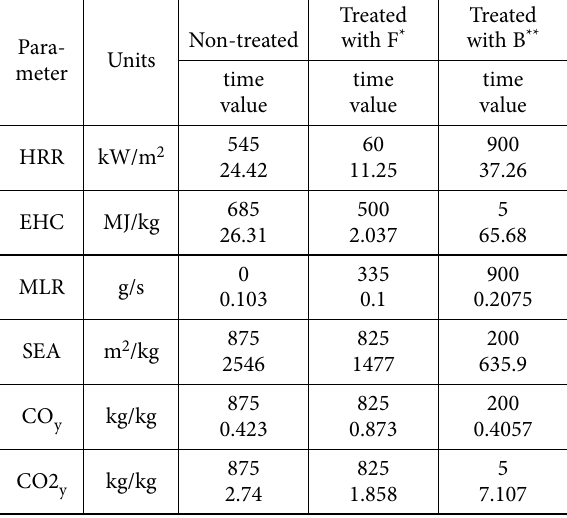
Table 2. Maximum values of selected combustion parameters and corresponding times for non-treated and treated pine timber specimens (without piloted ignition) Para-